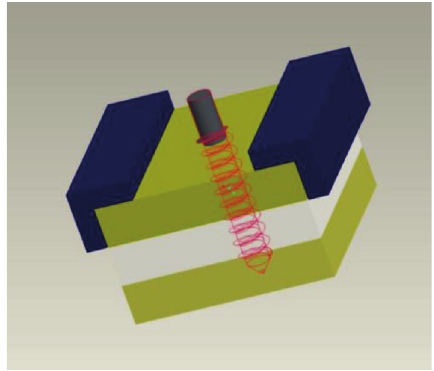
Figure 2: The Pro/E 3D assembly for the screw-pull out finite element